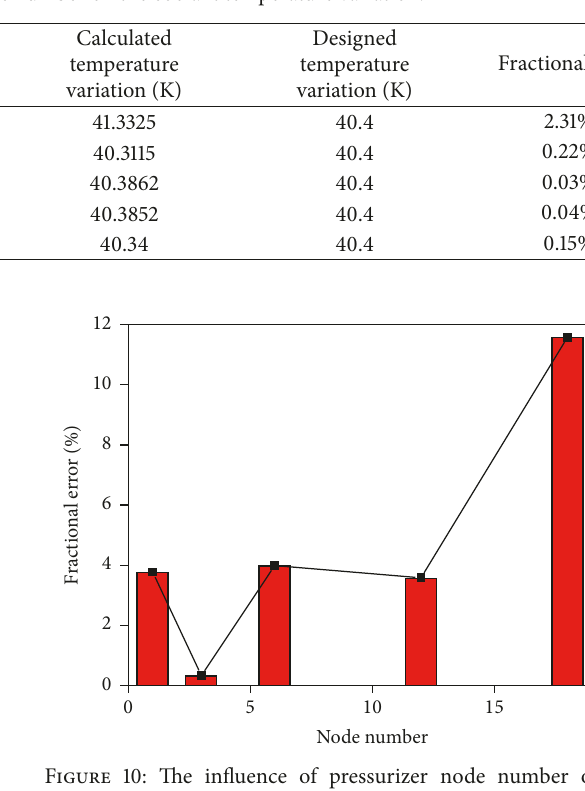
Table 10: The influence of pressurizer node number on the coolant temperature variation.